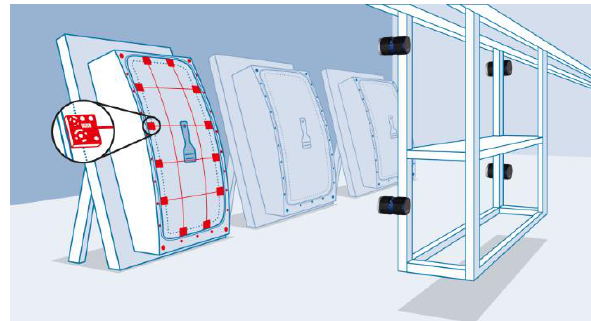
Figure 17: Special targets to measure flush and gap